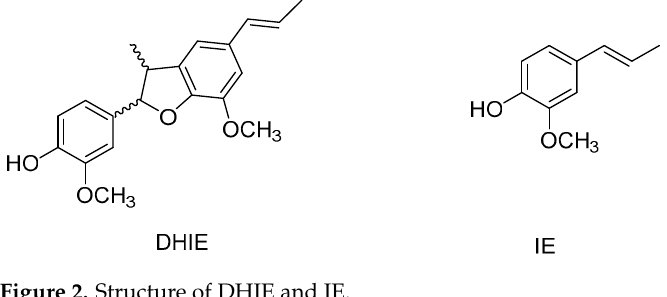
Figure 2. Structure of DHIE and IE.